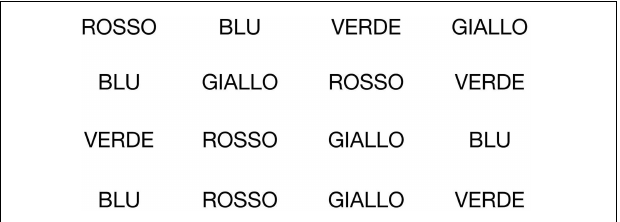
FIGURE 1 | Reading Without Interference (RWoI).